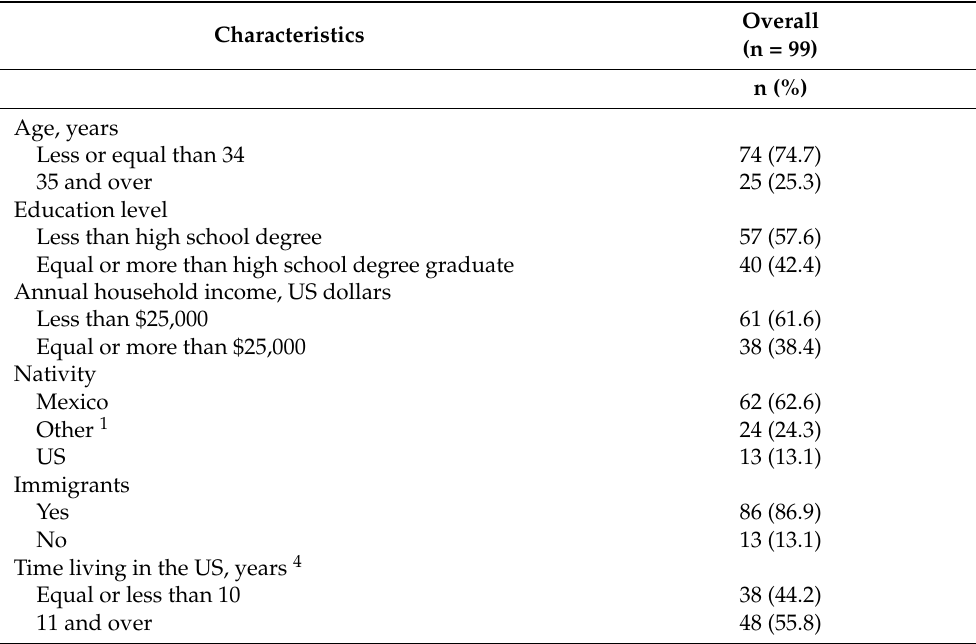
Table 1. Demographic characteristics of Latina women participating in a DHA supplement study during